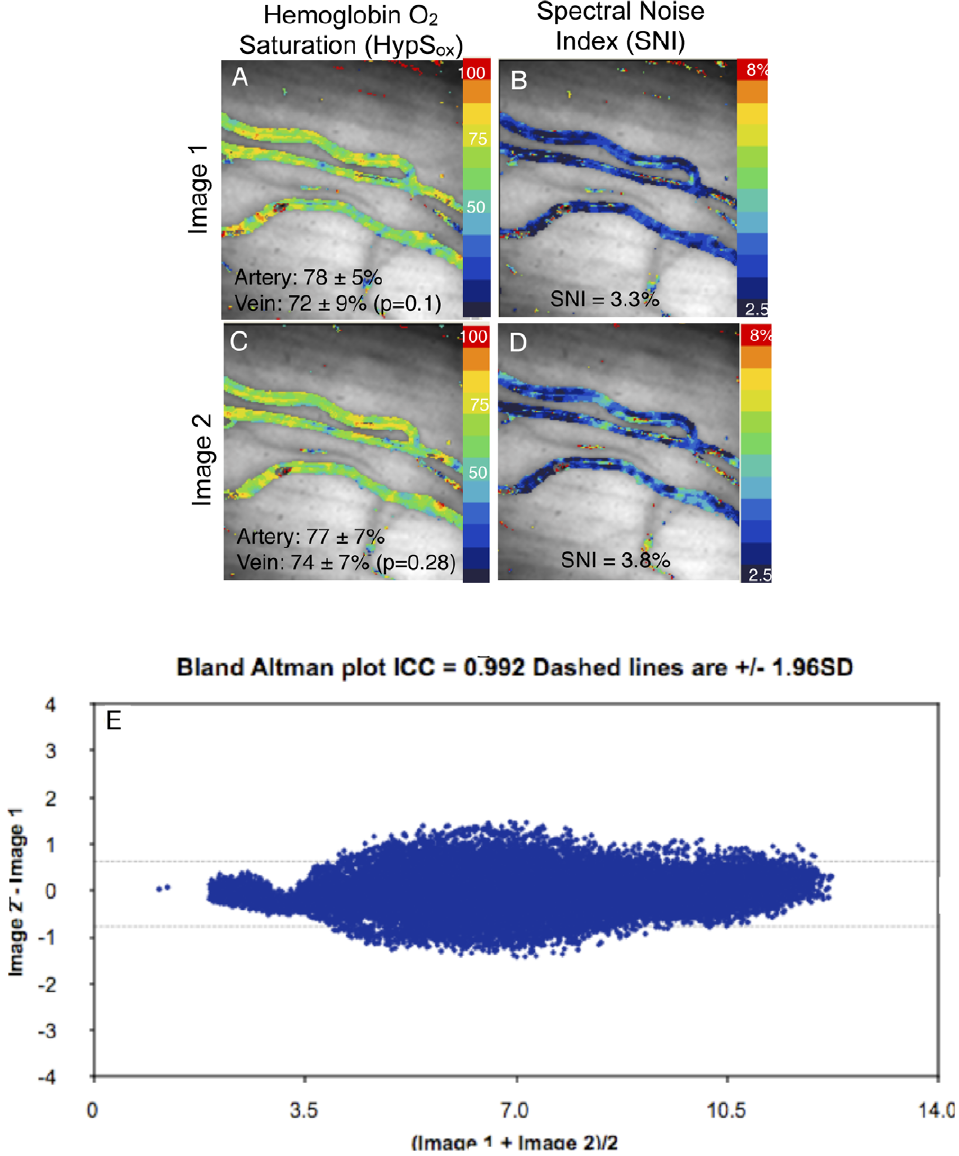
Figure 7. Spectral Noise Analysis. Two separate hemoglobin oxygen saturation measurements (HypS ox ) from the same scene within one second intervals during ischemia (A,C). Sequential images were acquired during the ischemia phase of the experiment in Figure 4. Although there are very small changes in the qualitative patterns of hemoglobin oxygen saturation between the two images there is no difference in the average retinal arterial saturation or venous saturation between images (Artery: 78 6 5% versus 77 6 7%, p=0.84, n=10; Vein: 72 6 9% versus 74 6 7%, p=0.30, n=10, paired, two-tailed Student T-test) or within images (see panels for within image comparison). (B,D) Spectral noise maps were made from spectral noise index (SNI) calculations as described in the methods section. Noise maps illustrate the average percent variability for all wavelength intensities from one pixel to another. The SNI is an average of the variability for the whole image. (E) Pixel-to-pixel correlation of wavelength intensity for representative wavelengths demonstrates excellent correlation between two independent measurements of the same scene (ICC